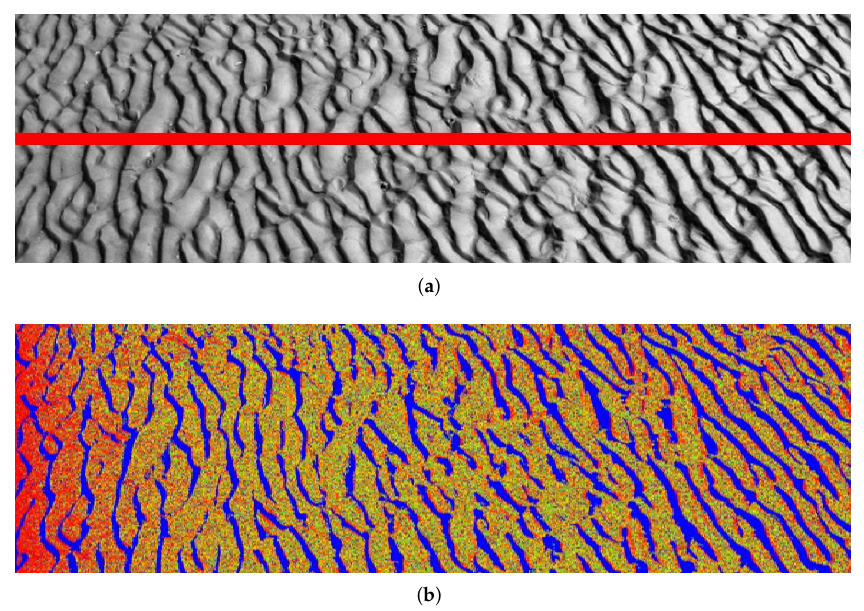
Figure 1. Extracted wave patterns. The color of each pixel indicates the curvature value (red: high, blue: low). ( a ) Base water flow (red line: evaluation region, see Figure 2). ( b ) Intrinsic patterns of foam with Kim et al.